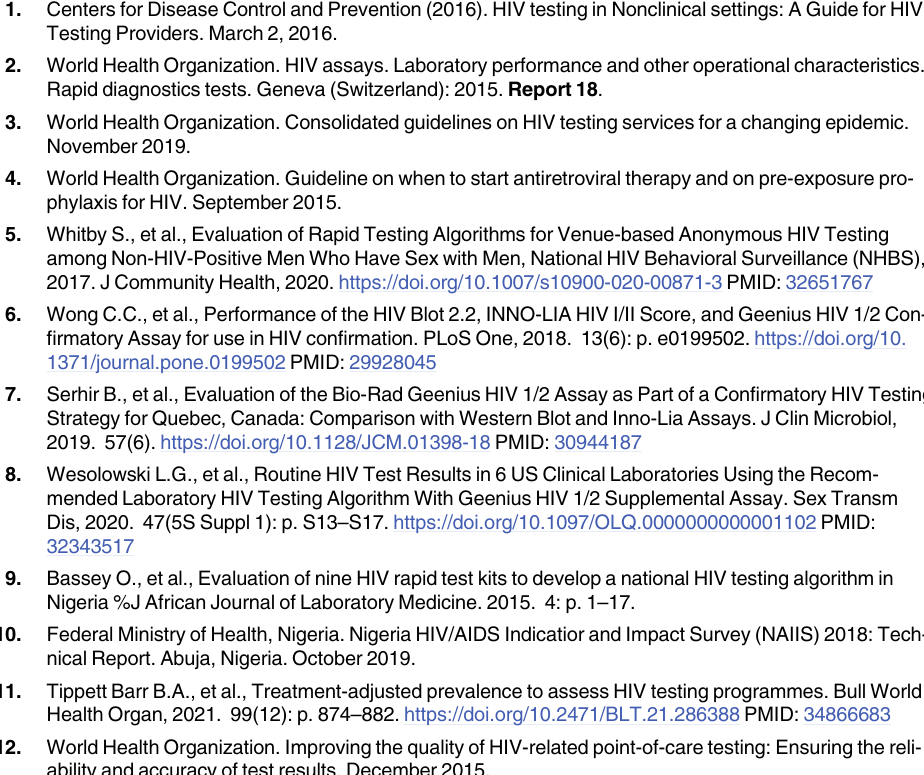
S1 Table. Raw data used for